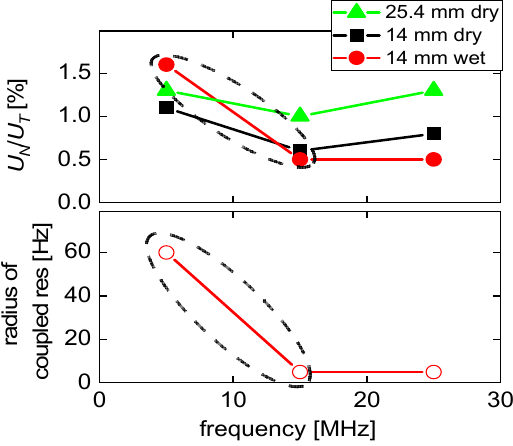
Figure 8. Results from Table 1 and Table 3 displayed in graphical form. U N / U T -ratios and the radius of the circle in the polar diagram (Figure 7(C)) both decrease when going from 5 MHz to 15 MHz.